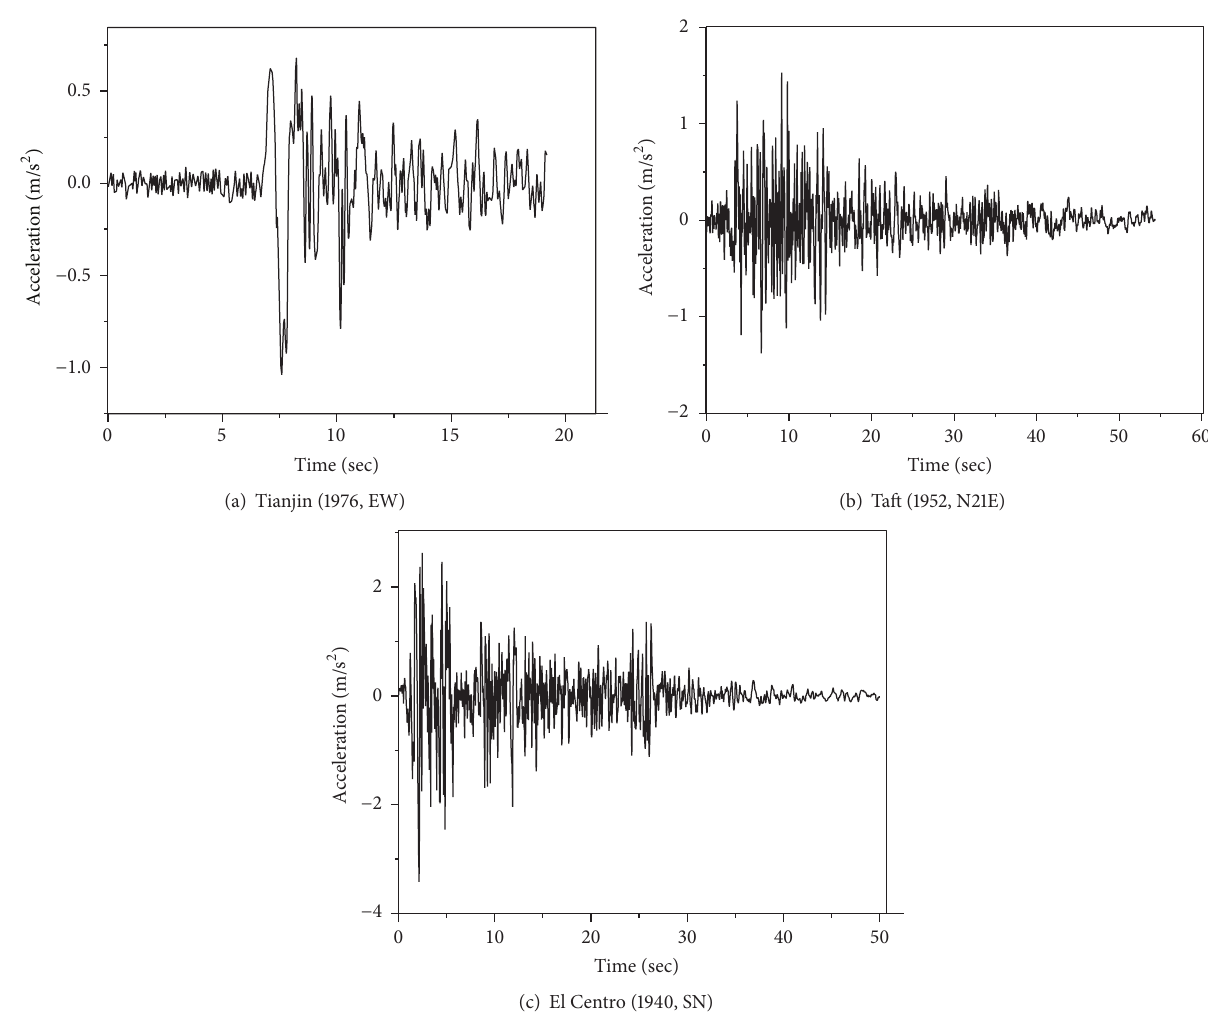
Figure 6: Acceleration time history curves of three earthquake